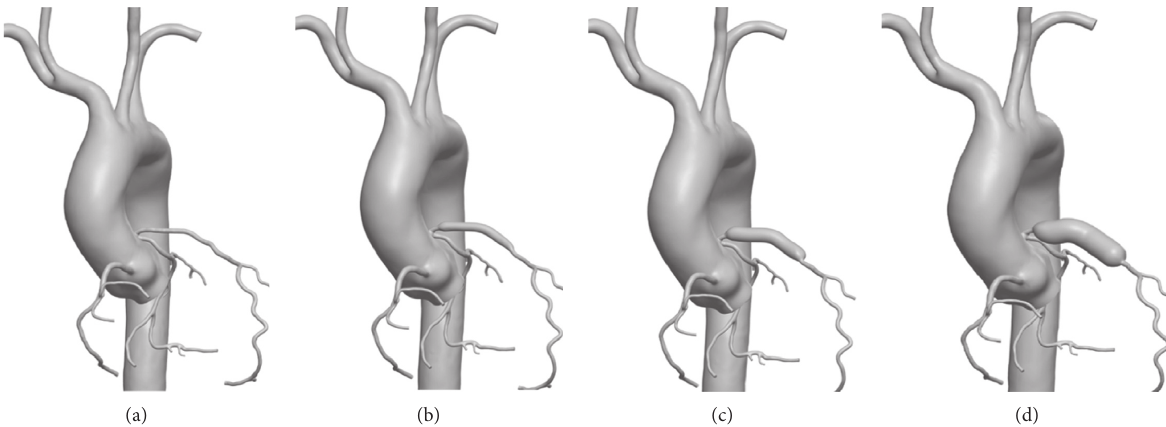
Figure 1: Three-dimensional models with a normal coronary artery (Model 0) and with coronary artery aneurysms with diameters two, three, and five times that of the normal diameter (Models 2 x , 3 x , and 5 x , respectively). (a) Model 0. (b) Model 2 x . (c) Model 3 x . (d) Model 5 x .